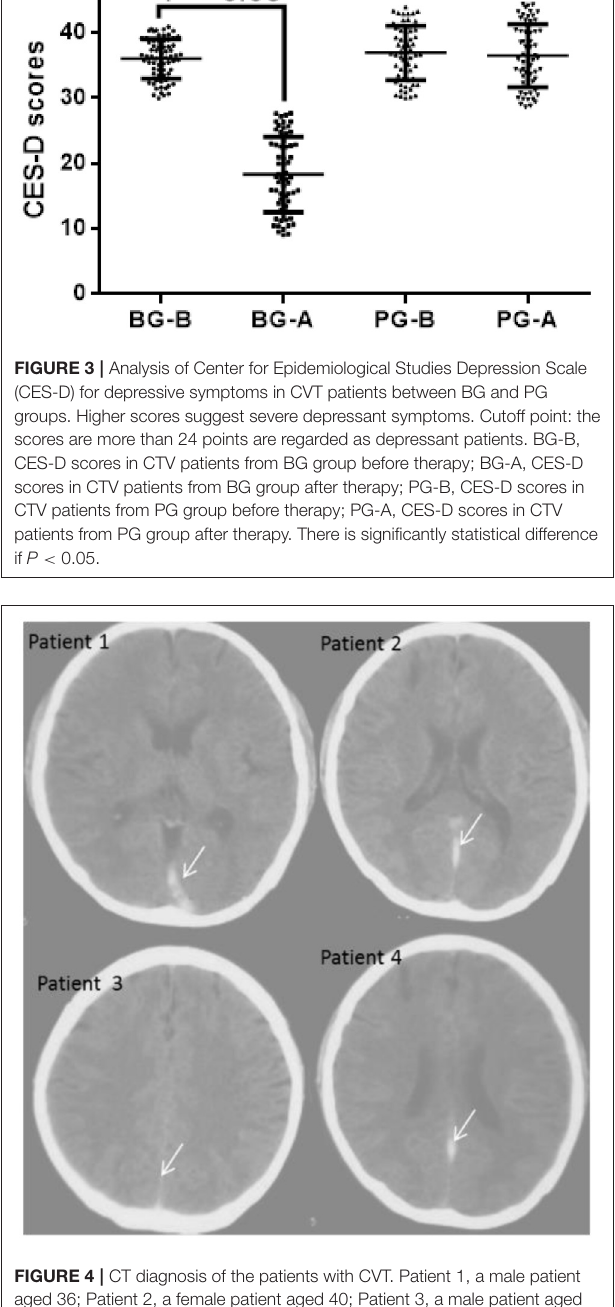
than the PG group ( P < 0.05, Figure 5C ). Cellular level